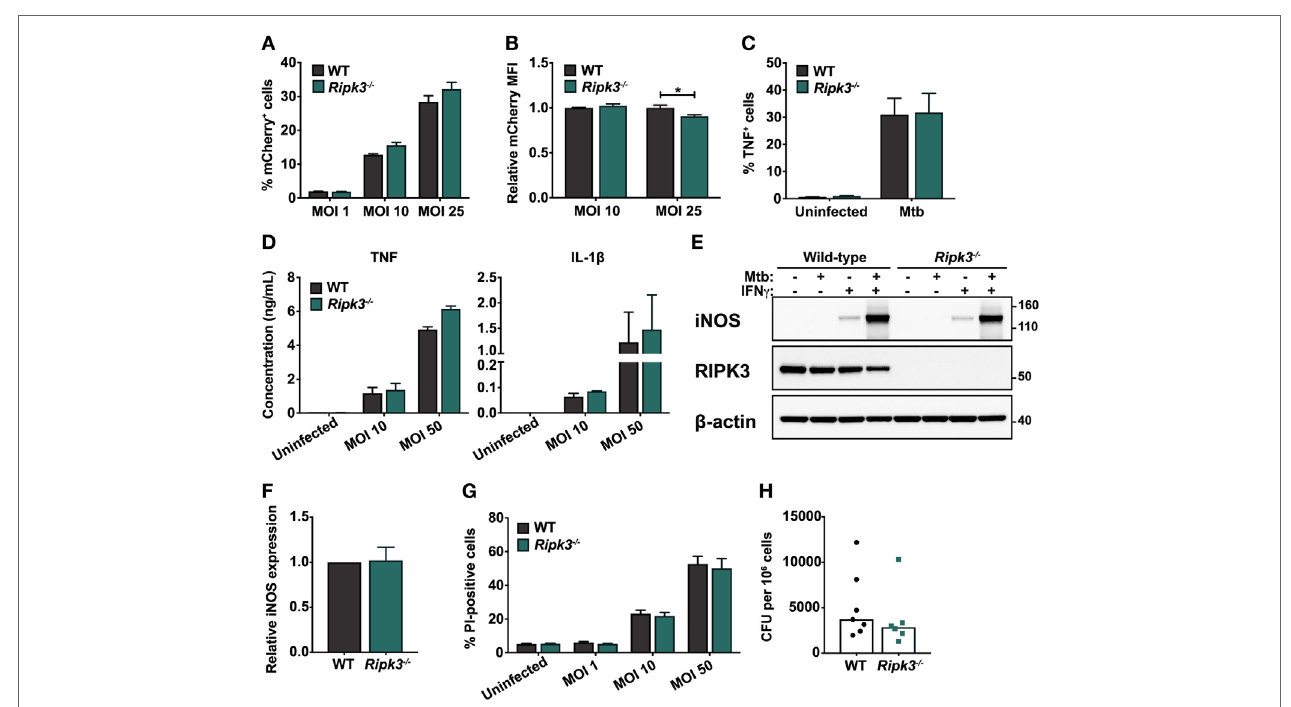
FigUre 1 | Responses of murine macrophages to Mycobacterium tuberculosis (Mtb) infection are unaltered by the loss of receptor-interacting protein kinase 3 (RIPK3). (a) Percentage of total bone marrow-derived macrophages (BMDMs) positive for mCherry fluorescence. Cells were infected with mCherry-expressing Mtb H37Rv for 4 h at the indicated multiplicities of infection (MOIs). (B) Relative median fluorescence intensity (MFI) of mCherry in mCherry-positive cells in (a) . (c) Percentage of total BMDMs producing TNF in response to Mtb infection. Cells were infected with Mtb for 4 h at an MOI of 25 and analyzed by intracellular cytokine staining and flow cytometry. (D) Concentrations of TNF and IL-1 β in culture supernatants of WT and Ripk3 − / − BMDMs 24 h post-infection with various MOIs of Mtb, determined by ELISA. (e) Western blot of inducible nitric oxide synthase (iNOS) expression in wild-type (WT) and Ripk3 − / − BMDMs infected with Mtb (MOI 10) and/or treated with IFN γ (50 ng/ml). Numbers to the right of the panels represent the positions of protein size markers (in kDa). (F) Densitometric quantitation of relative iNOS protein expression in BMDMs infected with Mtb and primed with IFN γ (adjusted for actin loading). (g) Death of WT and Ripk3 − / − BMDMs 48 h